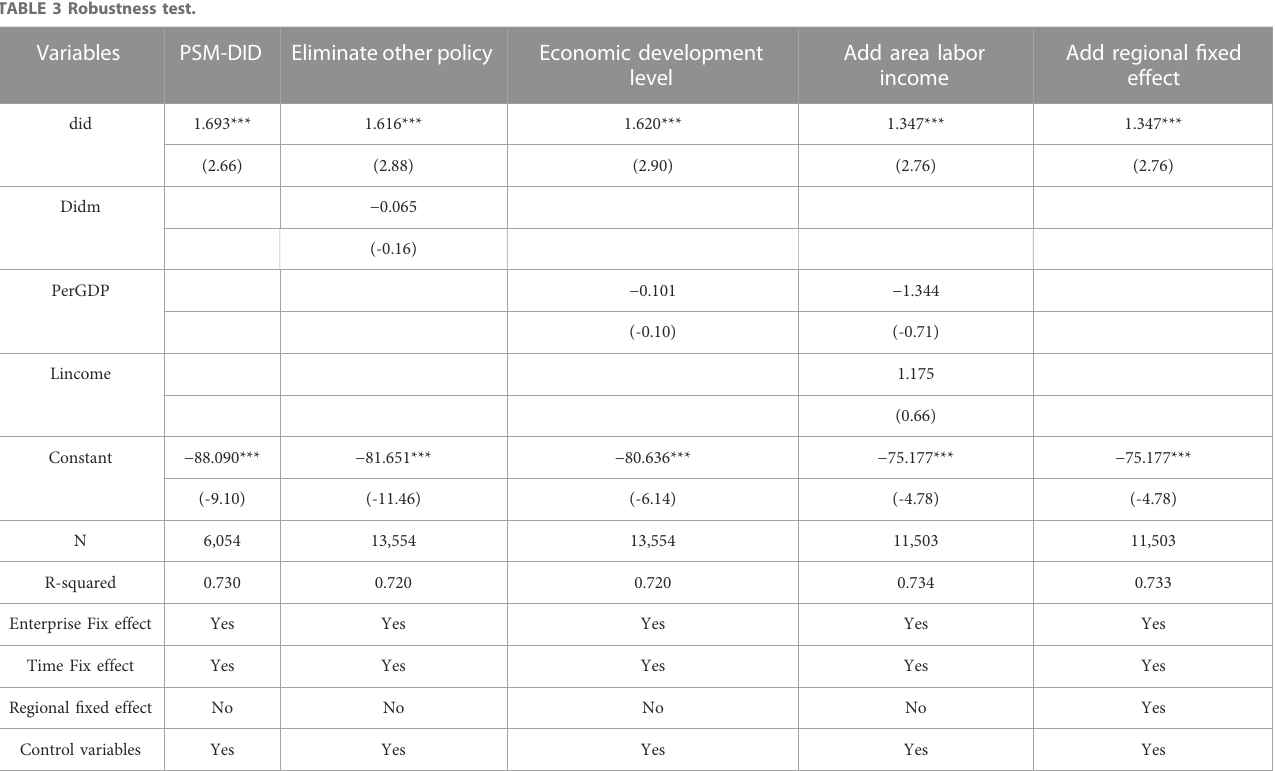
TABLE 3 Robustness